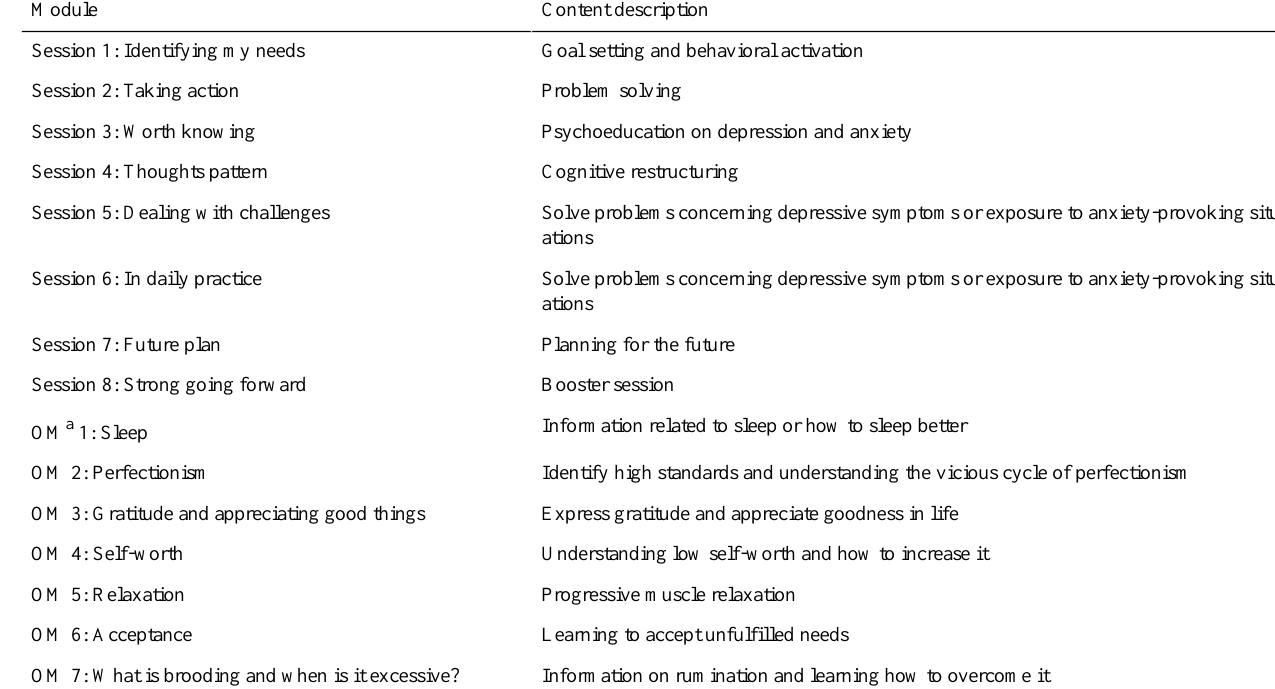
Table 2. The content of the intervention.